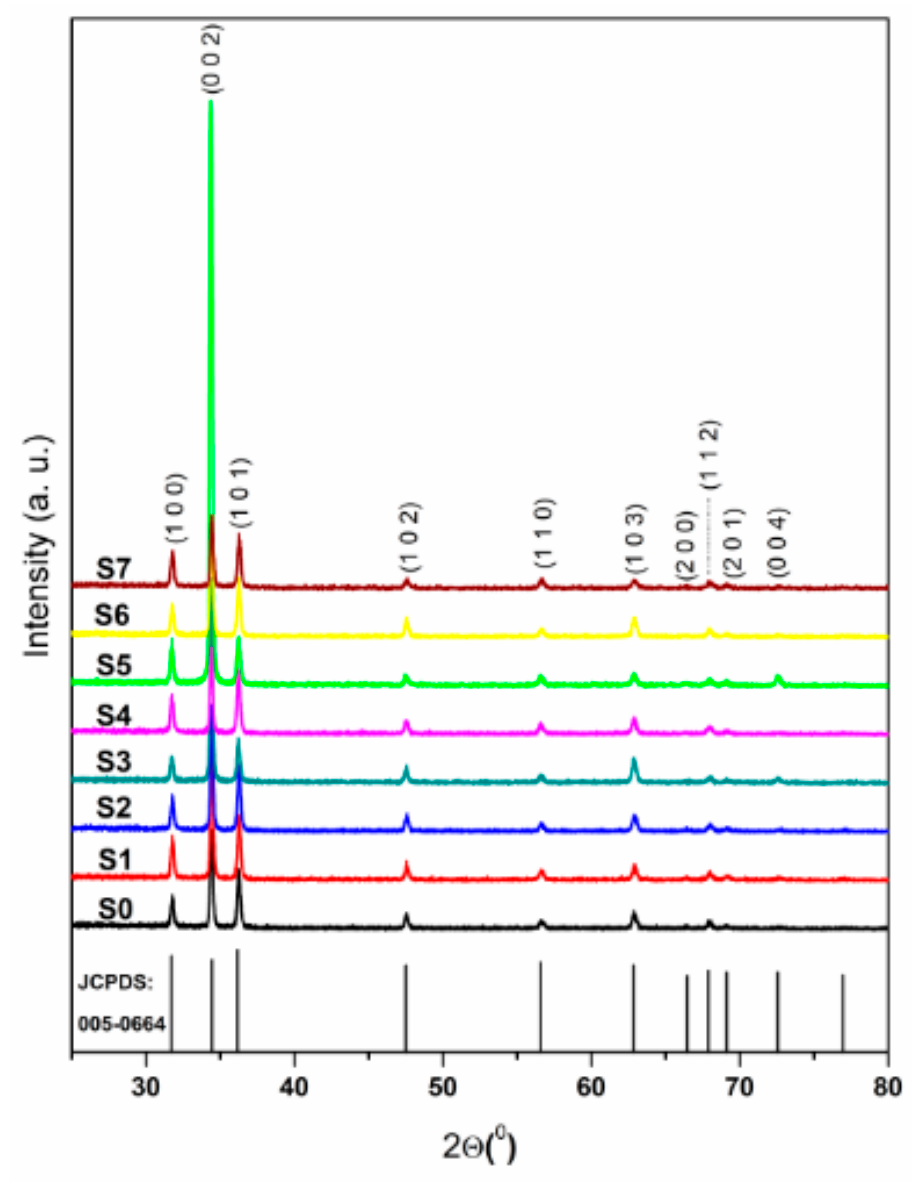
Figure 1. The X-ray diffraction patterns of pure ZnO and B-doped ZnO films.